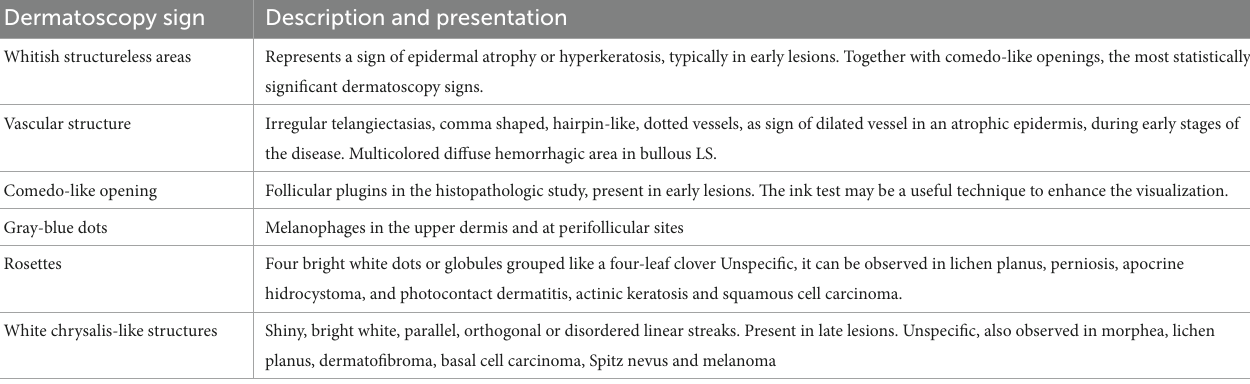
TABLE 3 Dermoscopy in lichen sclerosus